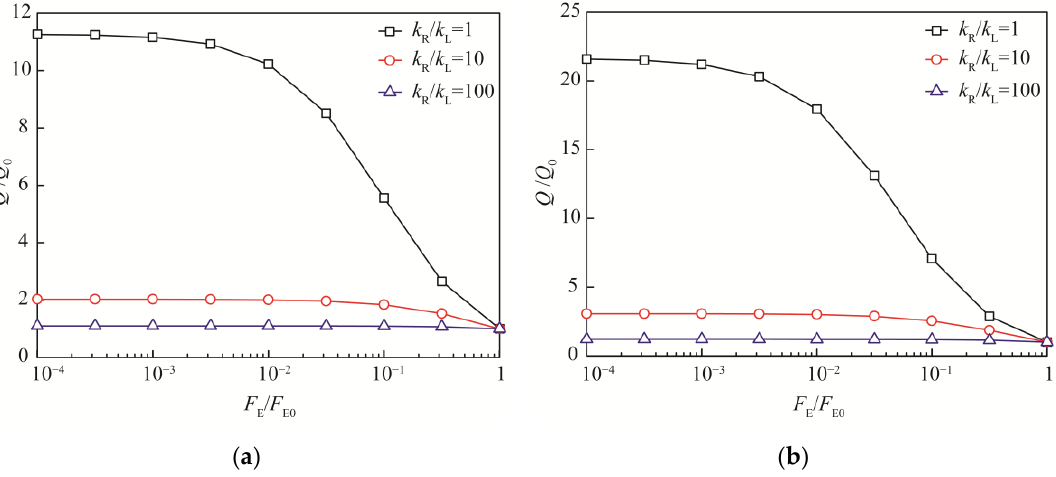
Figure 6. Relationship between Q / Q 0 and F E / F E0 with different k R / k L values. ( a ) h / r L = 5; ( b ) h / r L = 50.